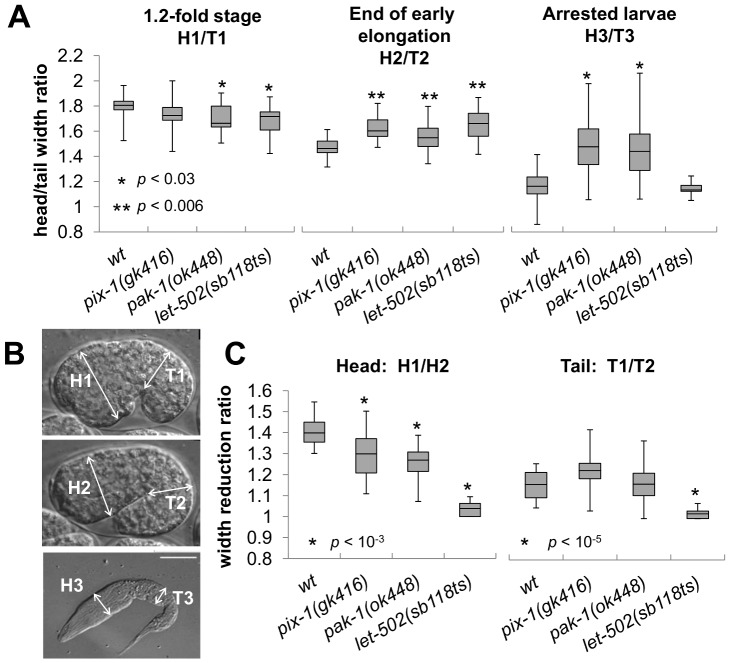

pix-1, pak-1 and let-502 control the head to tail width ratio of elongating embryos.Head (H) and tail (T) width are measured on 1.2-fold stage embryos (H1 and T1); at the end of early elongation (H2 and T2) and in arrested larvae (H3 and T3). In all panels of this figure animals were grown at 25.5°C. Embryos were collected through dissection of hermaphrodite grown at 25.5°C. Embryonic development is then recorded using 4-dimensional microscopy at 23–24°C. A) Distribution of ratio between the head and tail width of embryos at 1.2-fold stage (H1/T1; left panel), at the end of early elongation (H2/T2; middle panel) and of arrested larvae (H3/T3; right panel) in wt, pix-1(gk416), pak-1(ok448) and let-502(sb118ts) mutants. B) Localisation of measured areas in embryos and larvae C) Distribution of the head (H1/H2) and tail (T1/T2) width reduction ratios during early elongation. The box-plots represent the min, max, 25th, 50th (median) and 75th percentiles of the populations. Student's T-test p-values are indicated